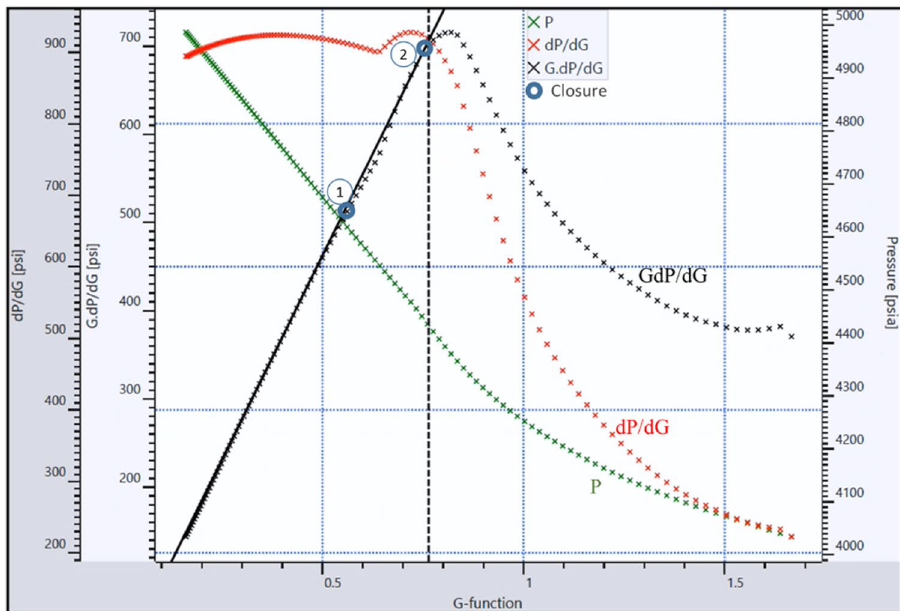
Fig. 23 A G-function plot for the DFIT test simulation with a single fracture with a strike of 25°. It is difficult to determine the closure pressure from this